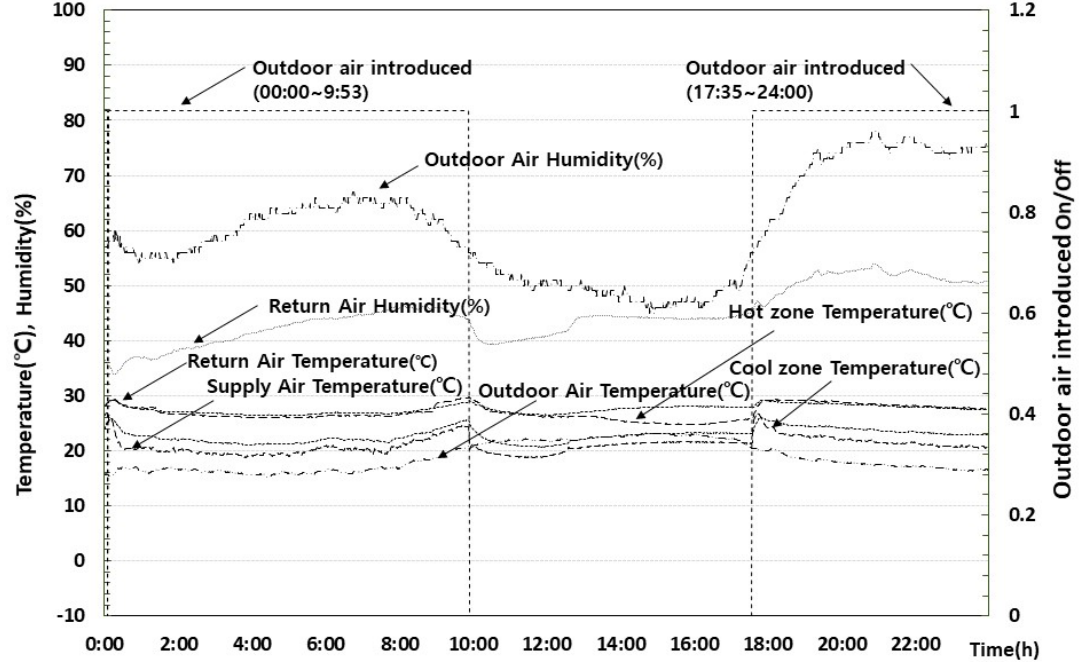
Figure 5. Time variation of indoor and outdoor air conditions at the test computer room for a typical day.